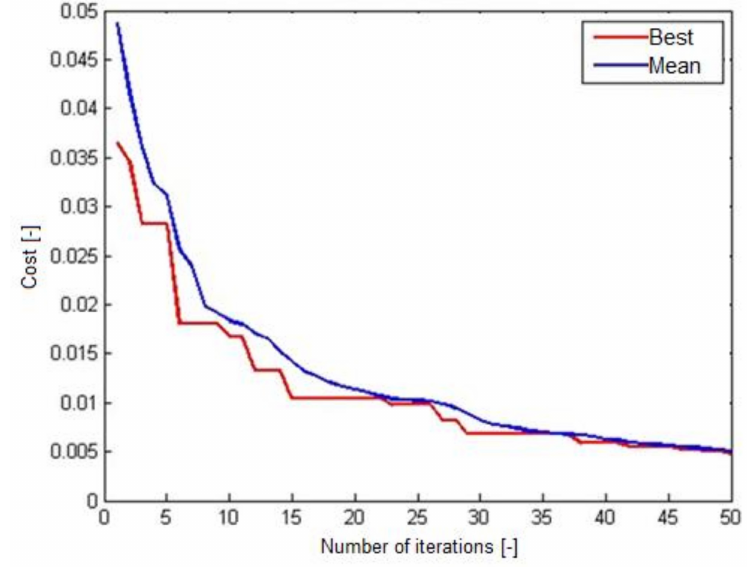
Figure 6. Chart in the FA-ANN with the optimum 8-8-4-1 structure.